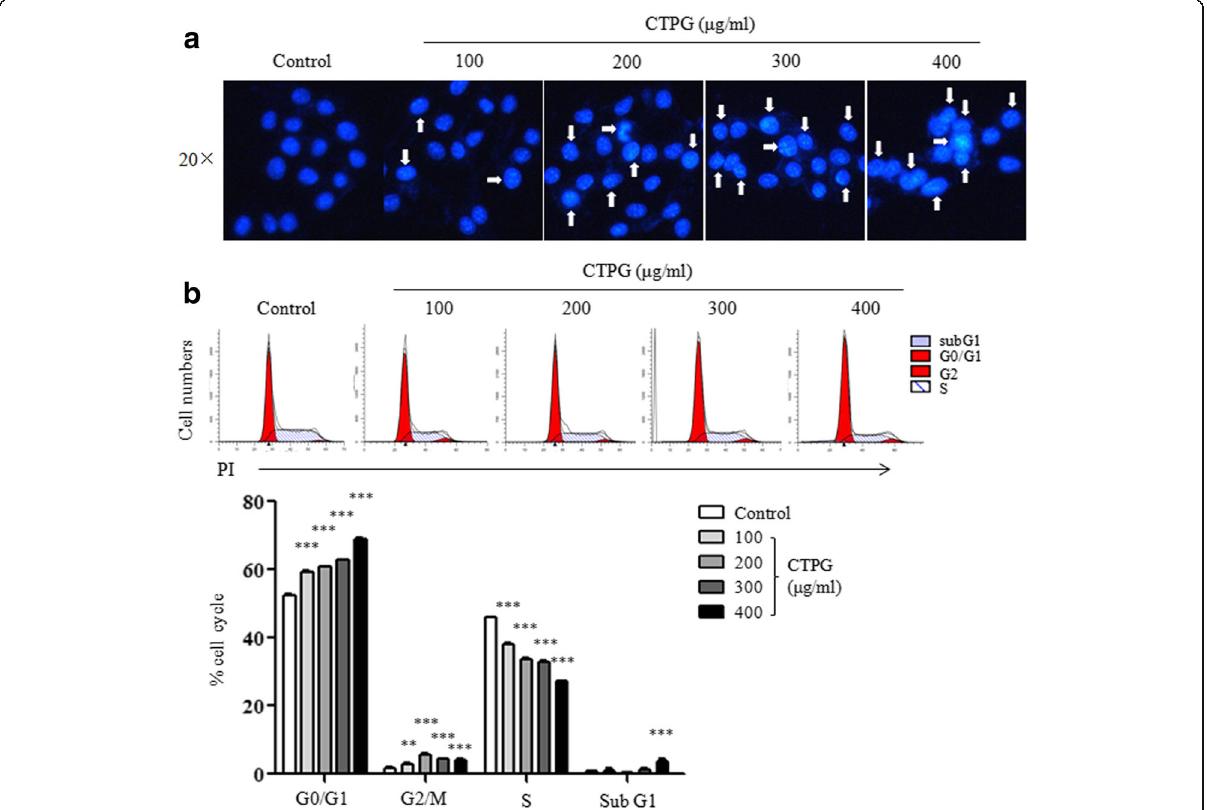
Fig. 3 CTPG induced chromosomal condensation and cell cycle arrest in H22 cells. H22 cells were treated with different concentrations of CTPG for 24 h. ( a ) Cells were stained with Hoechst 33,342 and observed by inverted fluorescent microscopy. The arrows indicated the chromosomal condensation or fragmentation. ( b ) Cell cycle distribution in H22 cells was analyzed by flow cytometry. ** p < 0.01; *** p < 0.001 compared to